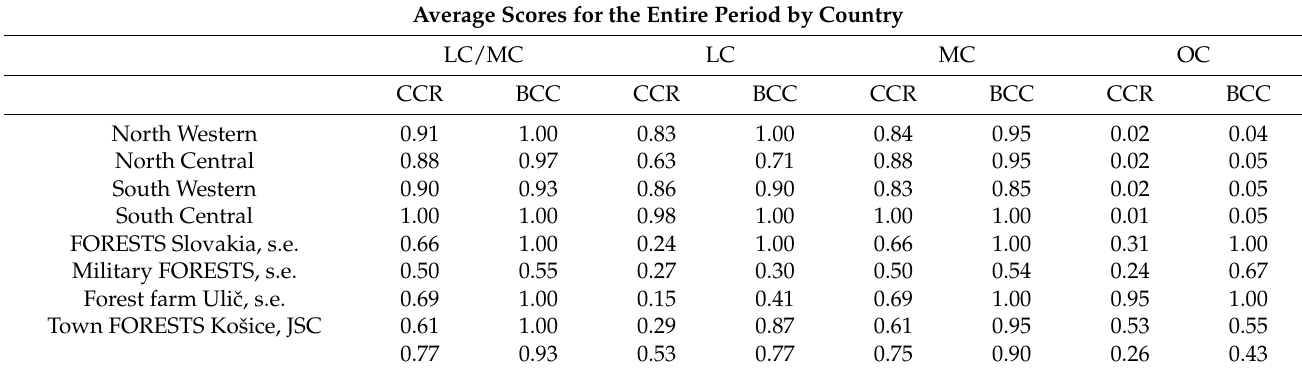
Table 2. Average scores for the entire period by enterprise and country with statistical significance in scores, α = 0.05.